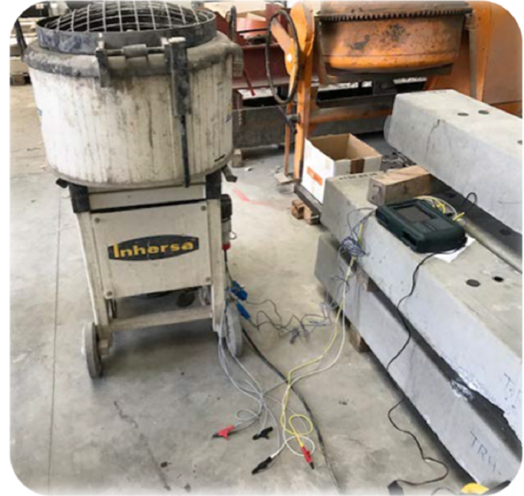
Figure 6. Instrument-fitted concrete mixer.